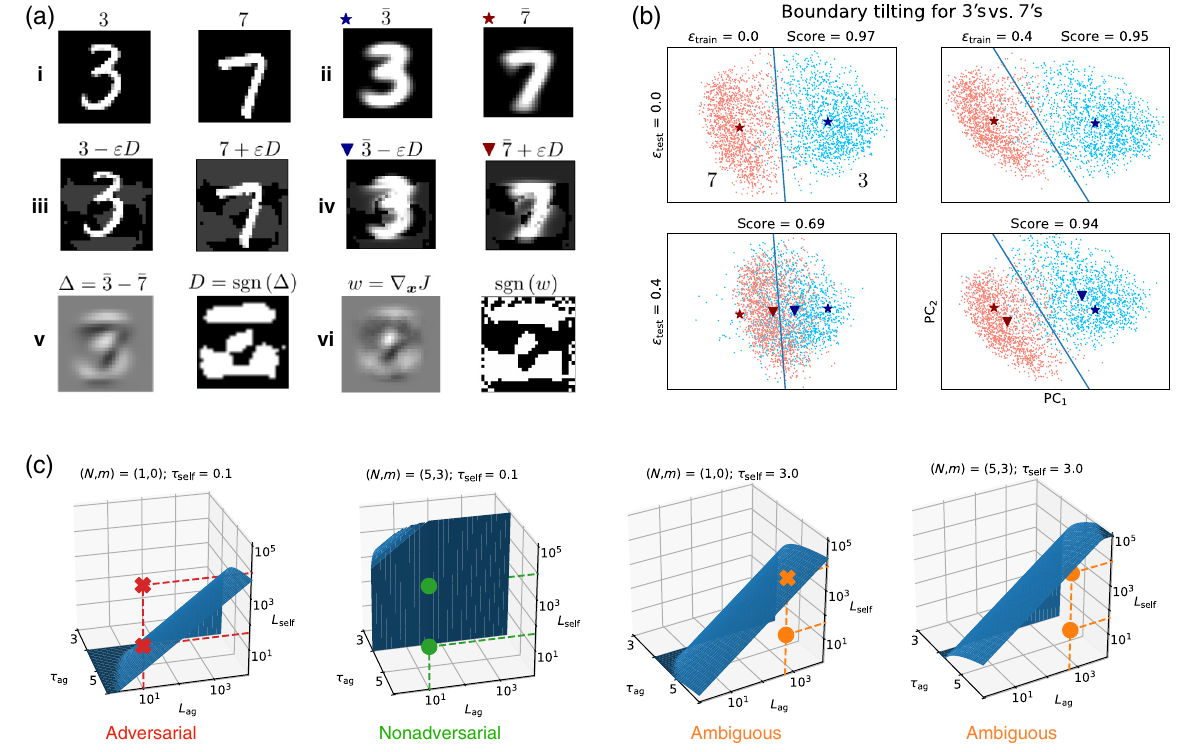
FIG. 6. Boundary tilting in one-dimensional digit classification. (a) (i) Typical 3 and 7 from MNIST. (ii) Average 3, 7 of the traditional ¯3 ¯7 test set, (iii, iv) with adversarial perturbation found by (v) subtracting the sign of from , which corresponds to (vi), the perturbation found with FGSM. (b) Projection of the digits on the first principal components. The classes are separated by a linear support vector classifier (blue), and the average of the classes with and without adversarial perturbation is shown by the triangle and star. We cycle through permutations of adversarial training and/or adversarial testing. Note how the boundary tilts in the right panels and how the triangle moves parallel to the decision boundary. (c) Decision boundary of the immune model. The region under the surface is the response regime, and the region above is the no-response regime. The classifier with a single proofreading step ð N; m Þ ¼ ð 1 ; 0 Þ fails to observe agonists in three of the four marked mixtures, while the robust classifier ð N; m Þ ¼ ð 5 ; 3 Þ correctly responds to each indicated mixture.